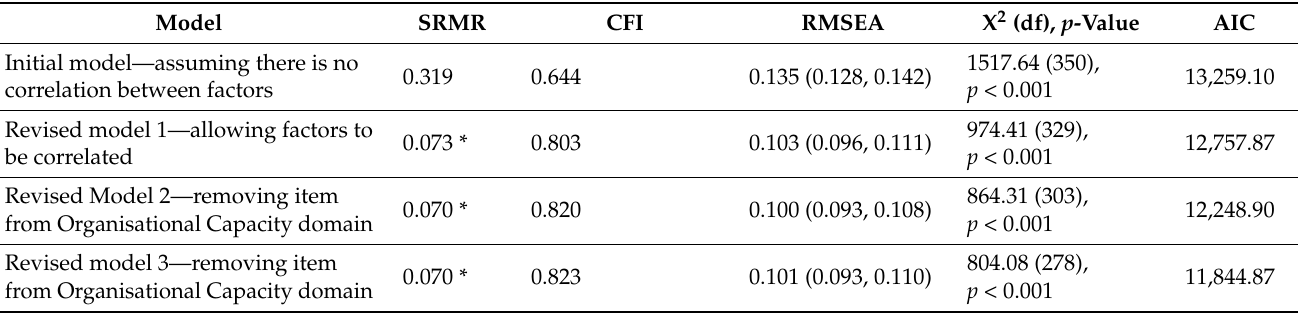
Table 3. Model fit statistics from confirmatory factor analysis ( n =